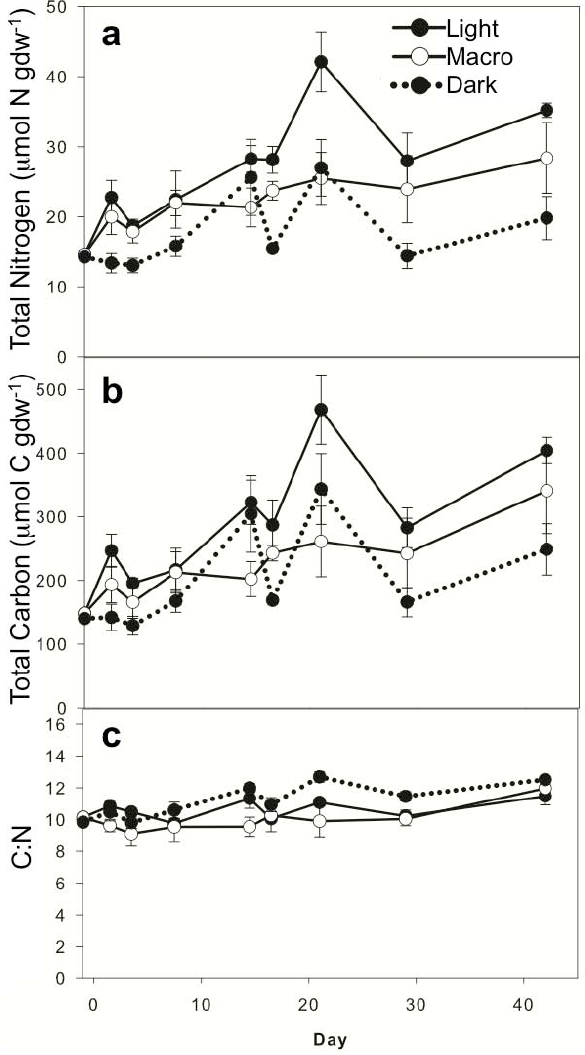
Fig. 2. Total nitrogen (a) and total organic carbon (b) concentrations and C:N (c) in surface (0–1cm) sediments. Values are mean ± SE ( n =